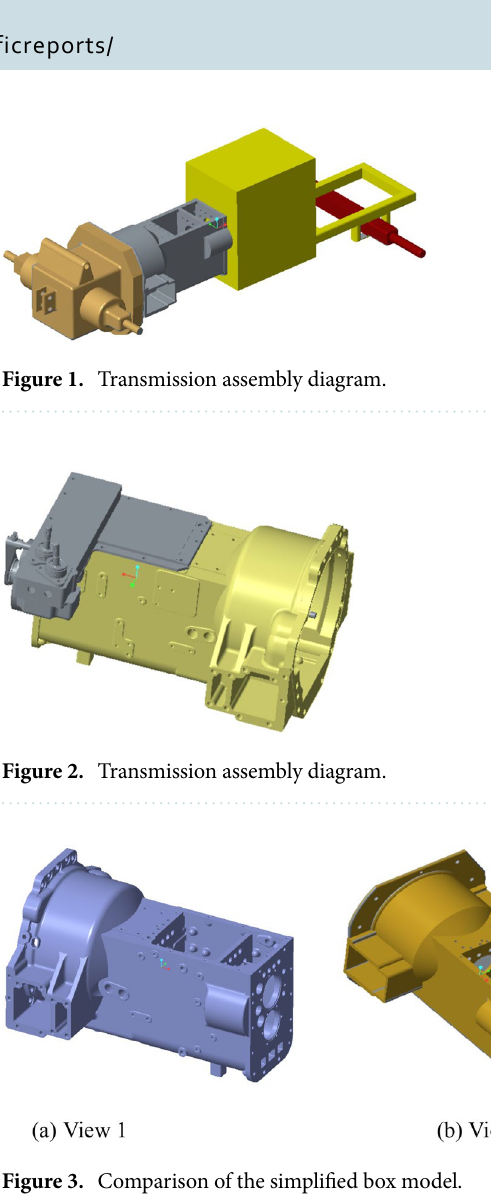
Figure 3. Comparison of the simplified box